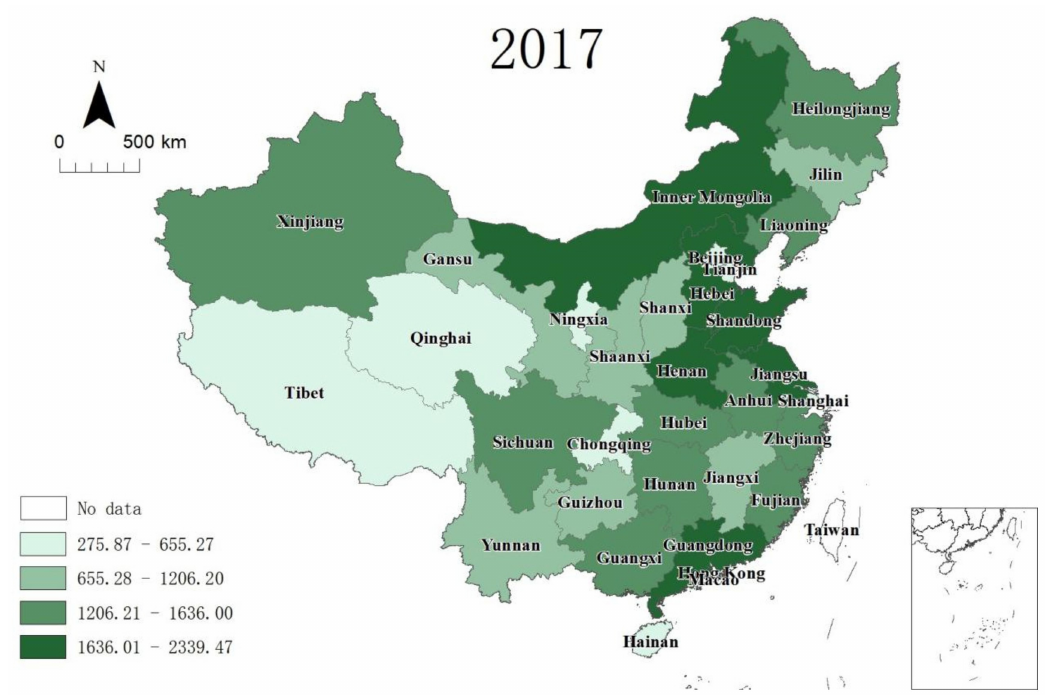
Figure 3. Transport land area in the 31 Chinese provinces in 2017. Data source: China Land and Resources Statistical Yearbook (2015–2017) [29].